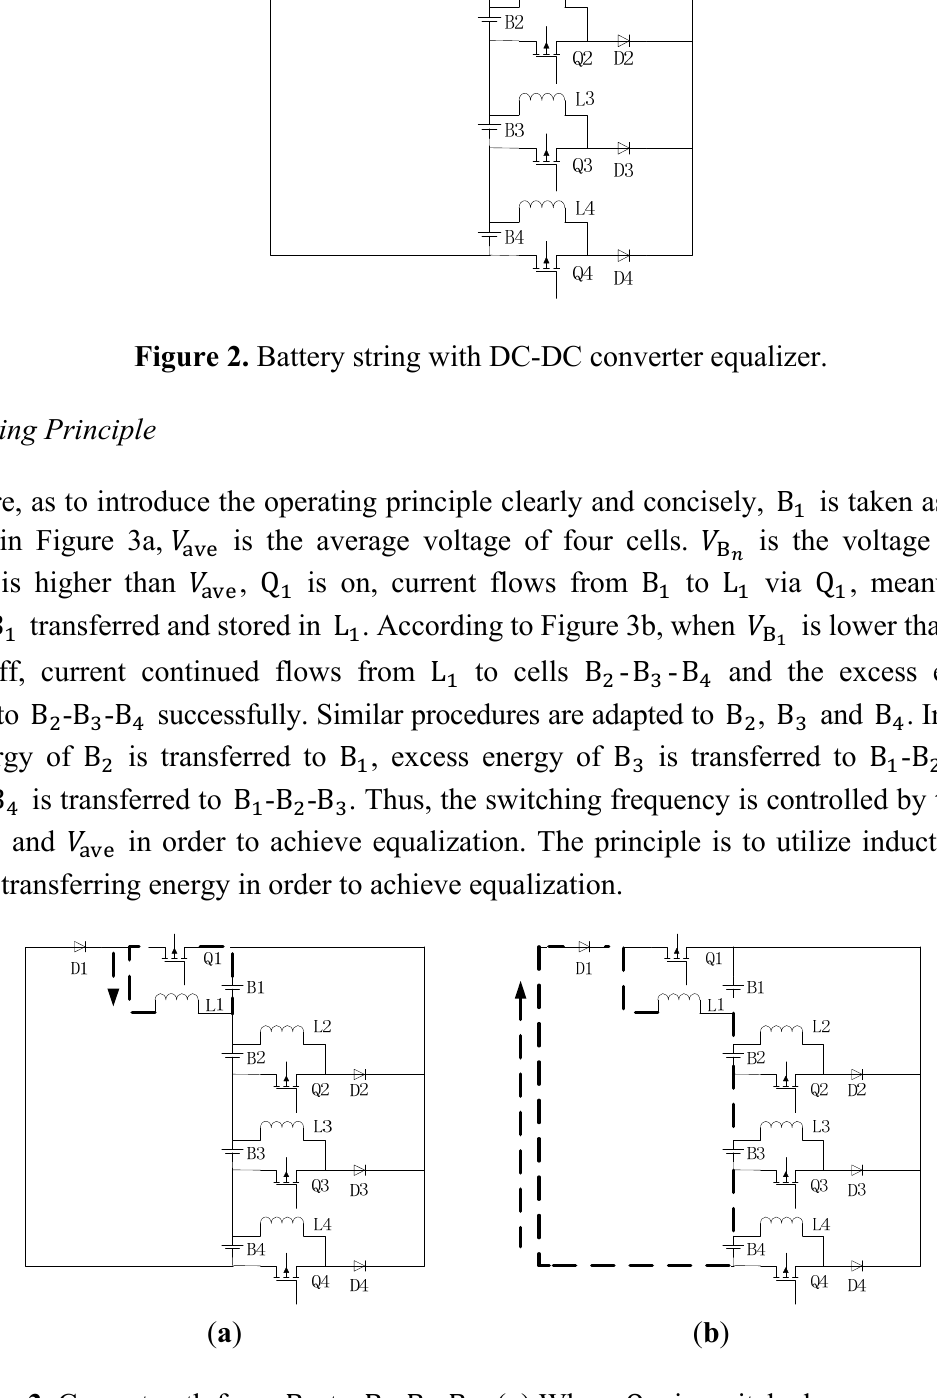
to B - B - B : ( a ) When Q (cid:2869) (cid:2870) (cid:2871) (cid:2872)